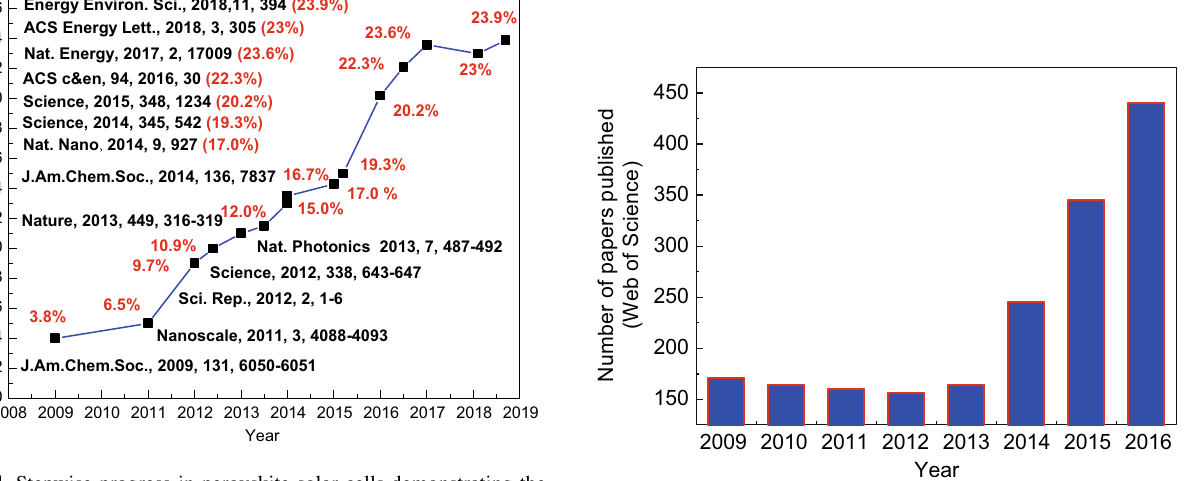
Fig. 4 Stepwise progress in perovskite solar cells demonstrating the remarkably sharp rise in photovoltaic performance over the past